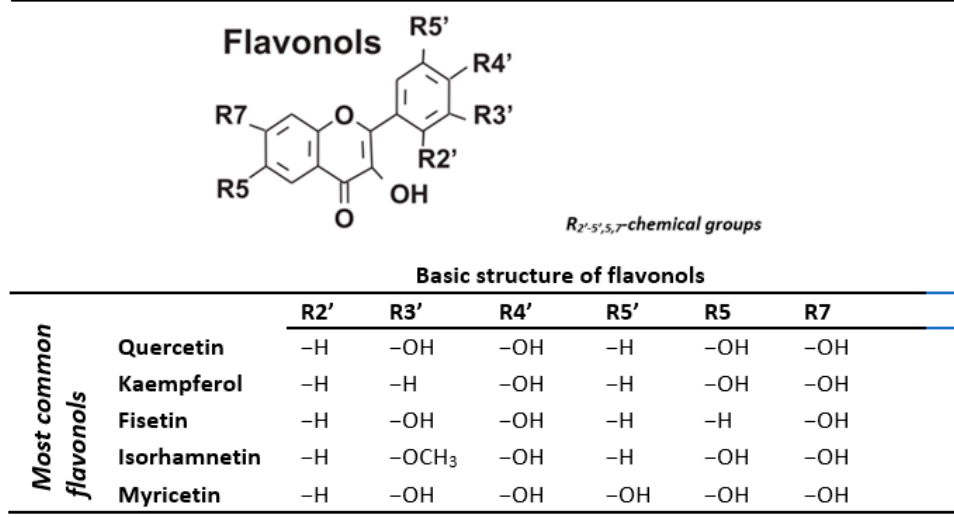
Figure 1. Chemical structure of the main flavonols present in plant food, based on [17,19].